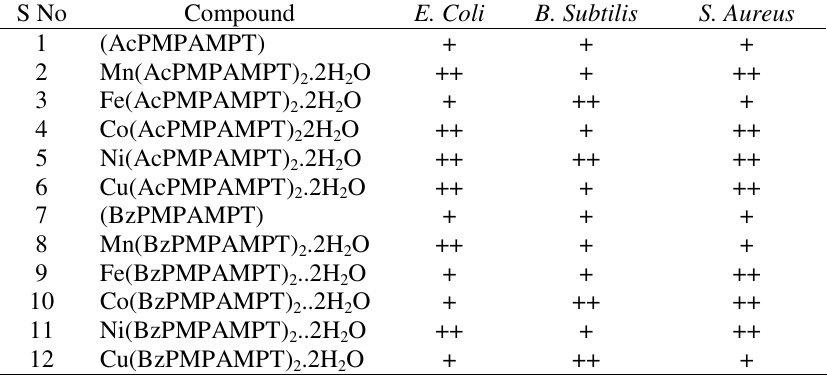
Table 2. Antibacterial activity of the